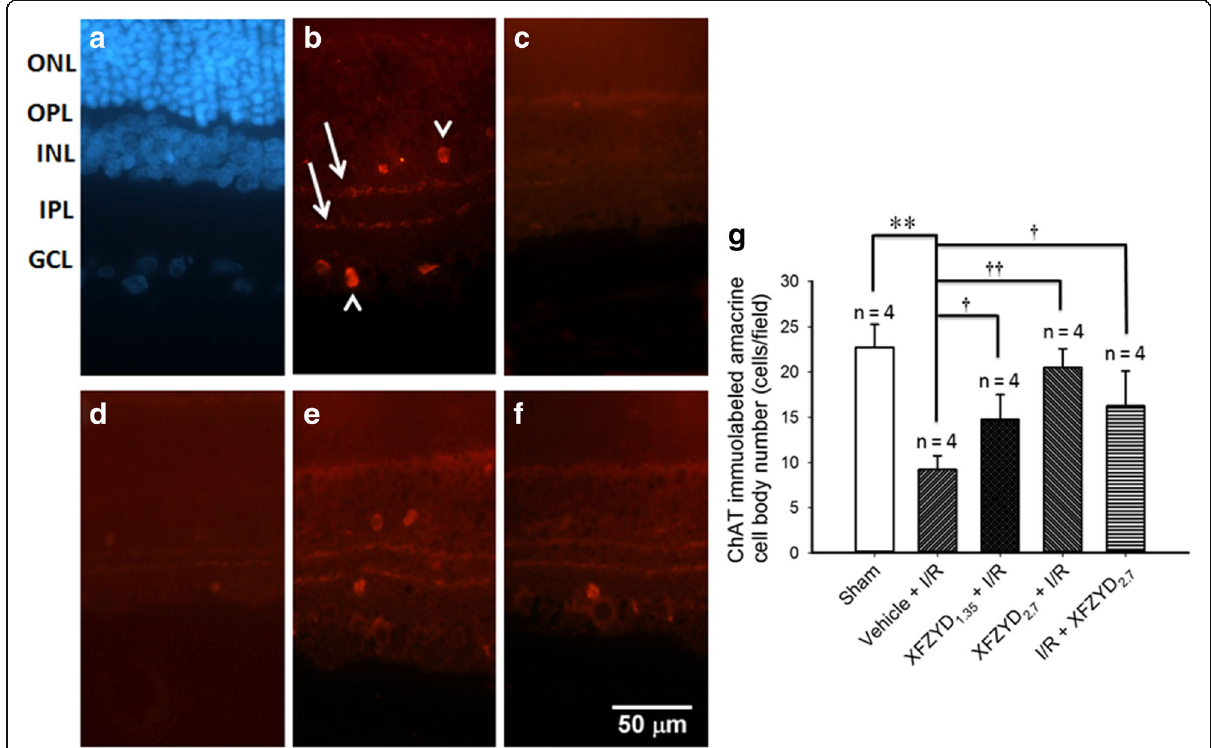
Fig. 4 Choline acetyltransferase (ChAT, red) immunohistochemistry. a is the retina subjected to the sham procedure (Sham) and the cellular nucleus is labeled with 4,6-diamidine-2-phenylindole dihydrochloride ( DAPI, blue ). b shows the amacrine cell bodies ( Sham; arrow heads ) located in the INL and the GCL and their neuronal fibers ( arrows ); these demonstrate two distinct bands in the IPL. c is from the retina that received I/R and preischemia administration of vehicle; there is a drastic decrease in the IPL immunolabelling as well as the amacrine cell body number. d , e , f are sections from the retinas that received I/R and preischemia administration of 1.35 g/kg/day XFZYD (d, XFZYD 1.35 + I/R), 2.7 g/kg/day XFZYD (e, XFZYD 2.7 + I/R) or postischemia administration of 2.7 g/kg/day XFZYD ( f , I/R + XFZYD 2.7 ). Moreover, these ischemia-induced alterations were clearly and dose-dependently alleviated when the ischemic retinas were preadministrated with 1.35 and 2.7 g/Kg/day XFZYD. Postischemia administration of 2.7 g/Kg/day XFZYD also clearly attenuated these ischemia-induced alterations. Each bar represents the mean values ± SD ( n = 4) following the sham procedure or I/R ( g ). ** indicates significance ( p < 0.01; Sham vs. Vehicle + I/R). † or †† indicates significance ( p < 0.05 or p < 0.01; Vehicle + I/R vs. XFZYD 1.35 + I/R, XFZYD 2.7 + I/R or I/R + XFZYD 2.7 ). The area of one field is approximately 0.25 mm 2 . Abbreviations: ONL, outer nuclear layer, OPL, outer plexiform layer, INL, inner nuclear layer, IPL, inner plexiform layer, GCL, ganglion cell layer. XFZYD, Xue-Fu-Zhu-Yu decoction. Scale bar = 50 μ